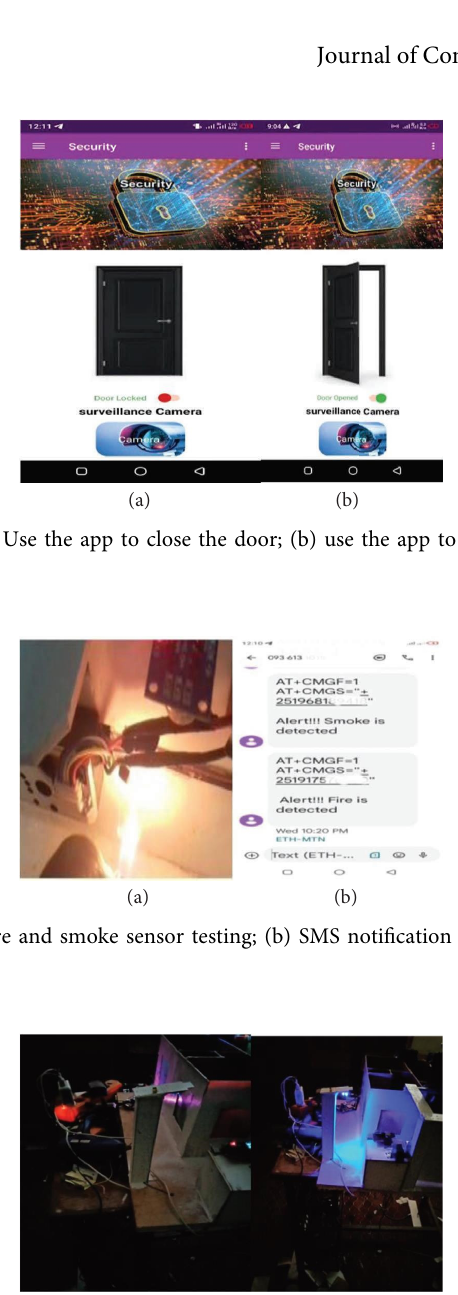
Figure 13: Outdoor light turns ON when it gets dark.